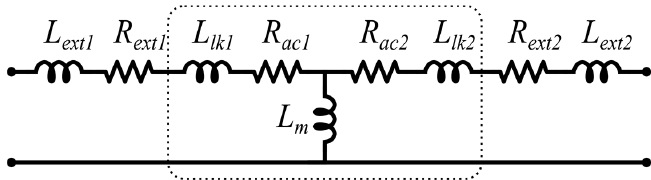
Figure 9. Equivalent circuit for transformer and external parasitics.